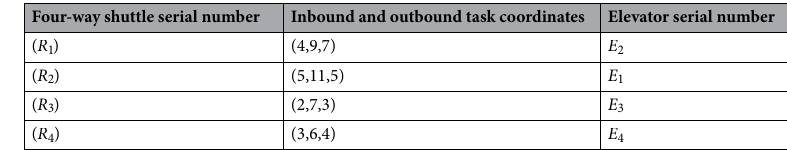
Table 6. According to the results of the algorithm, the optimal solution of the job is